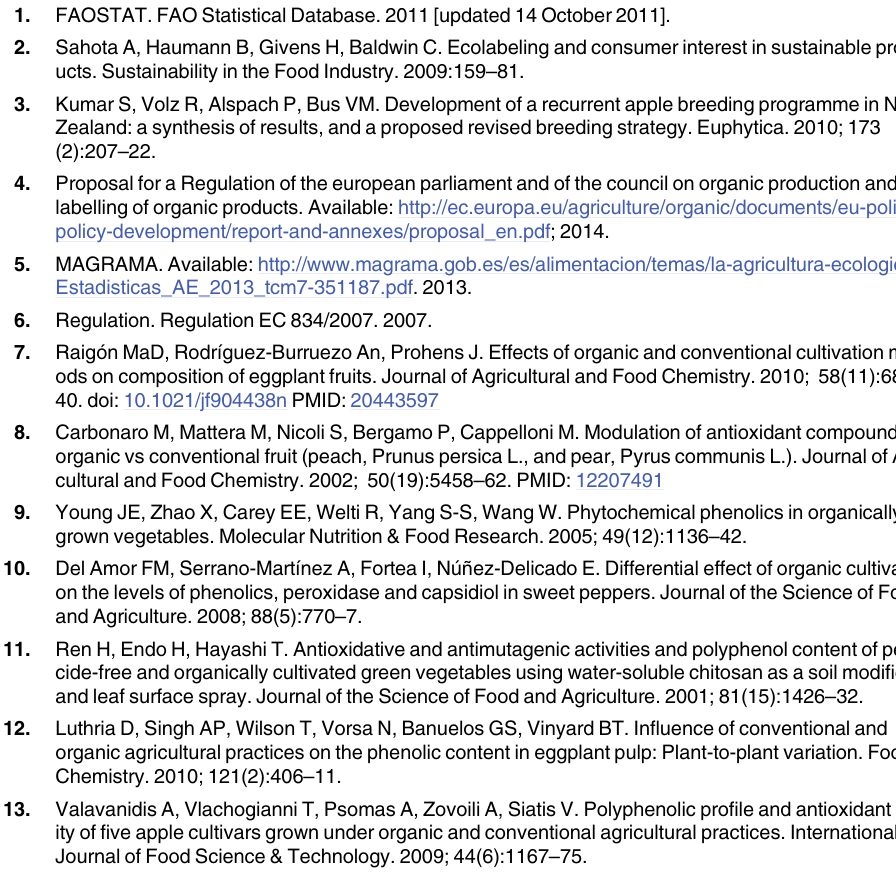
S2 Table. Pearson's correlation coefficients of hydrophilic extraction assays (TAC,TPC, ABTS-h, FRAP), lipophilic extraction assays (ABTS-l and TCC) and organic acids values. ns = non significant, (cid:4) = significant P < 0.05, (cid:4)(cid:4) = significant P < 0.01, (cid:4)(cid:4)(cid:4) = significant P <